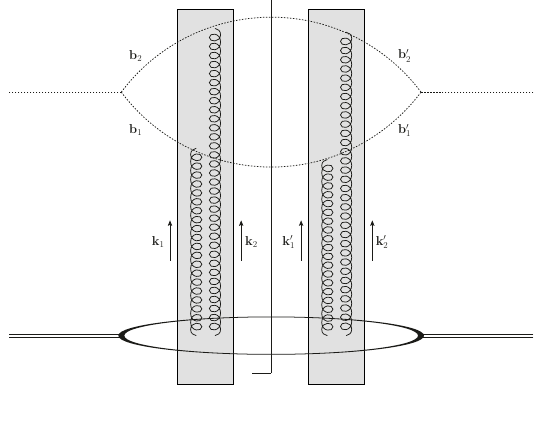
Figure 4 . 4-body